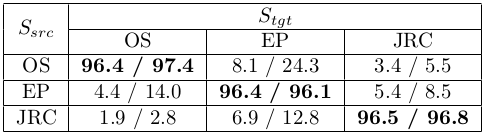
Table from the paper: Monolingual and Cross-lingual Zero-shot Style Transfer
Table text:
S src
S tgt
OS
EP
JRC
OS
96.4/97.4
8.1/24.3
3.4/5.5
EP
4.4/14.0
96.4/96.1
5.4/8.5
JRC
1.9/2.8
6.9/12.8
96.5/96.8